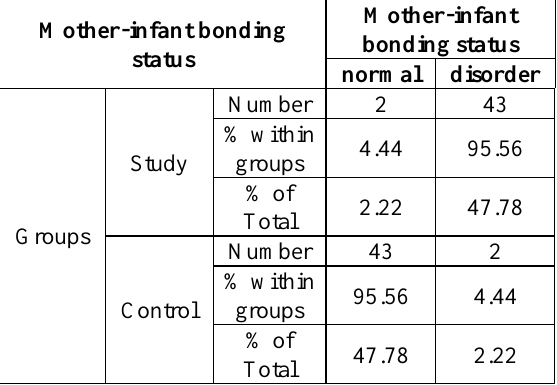
Table 1: Mother-infant bonding status